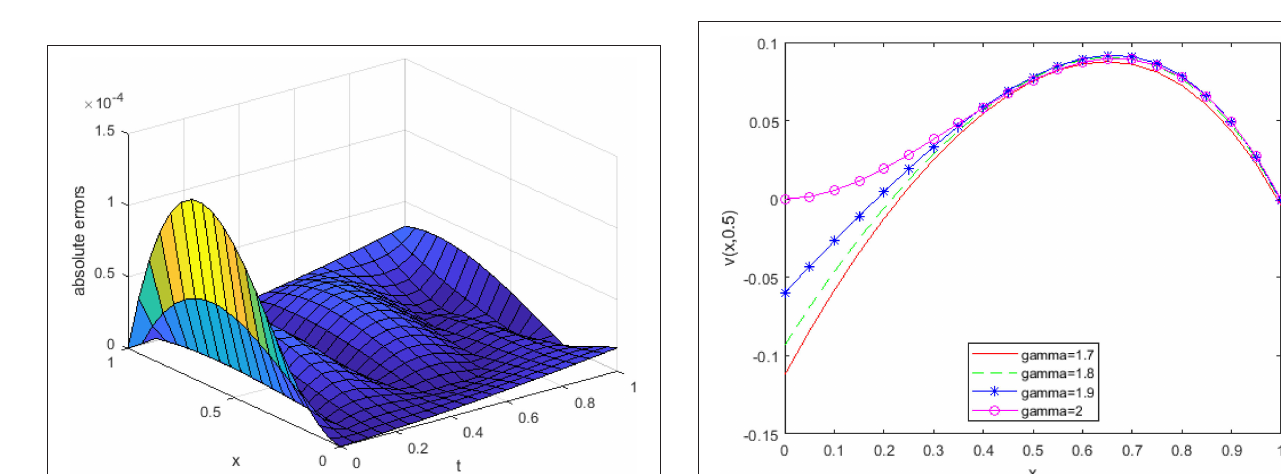
FIGURE 5 | Approximate solution at γ = 2.